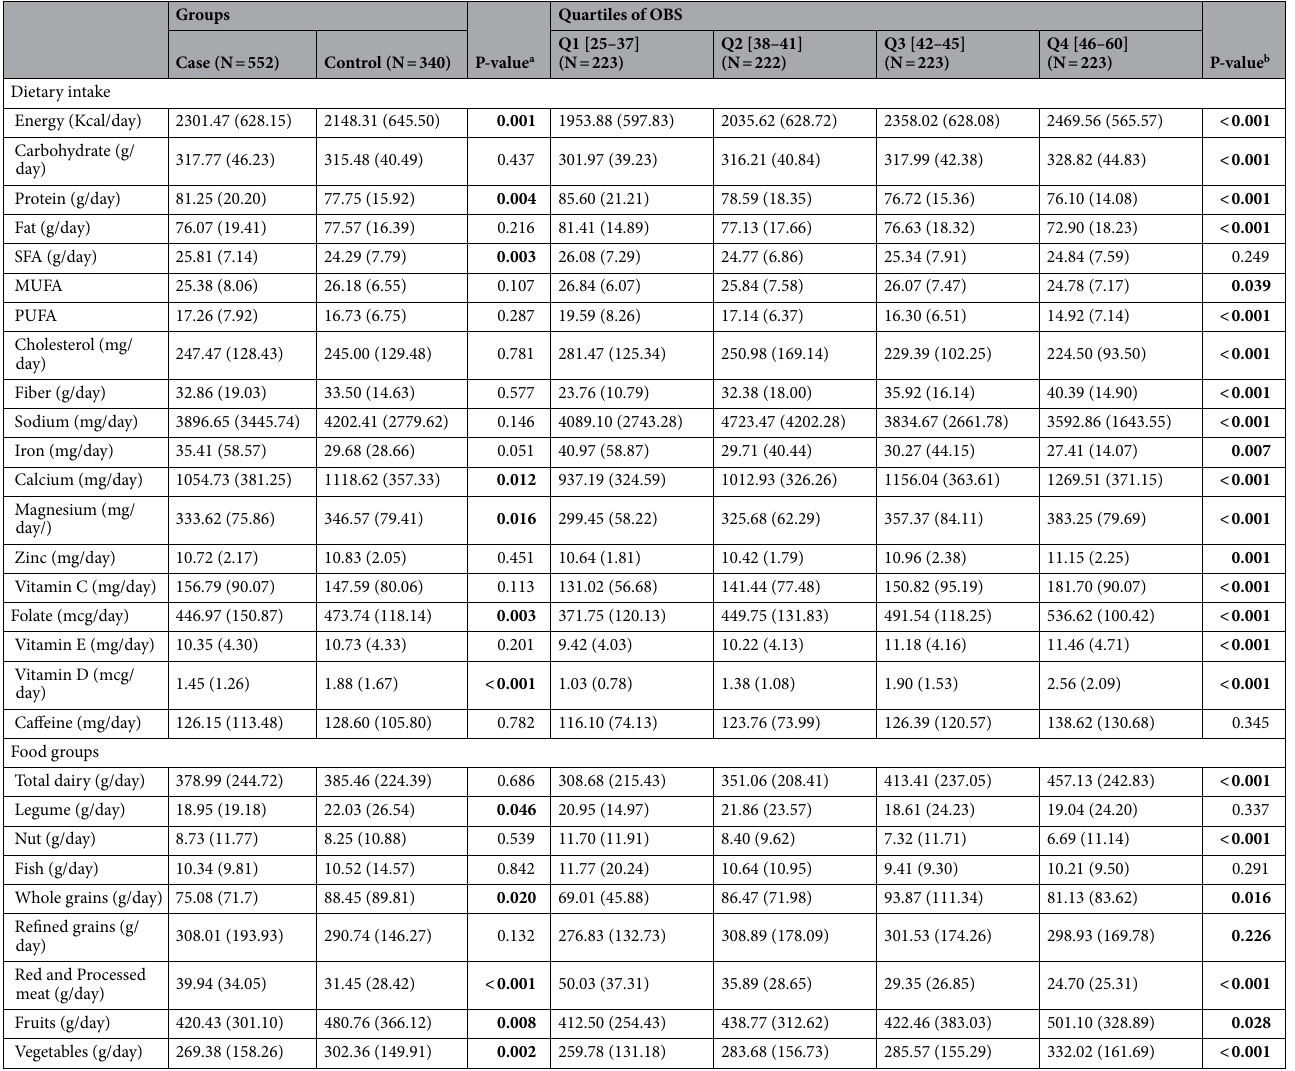
Table 2. Dietary intake between groups and across the Quartiles of oxidative balance score (OBS). Values are expressed as means (standard deviation (SD)) of 892 subjects. Nutrients were adjusted for total energy intake (kcal). Significant values are in bold. P-values are resulted from one way-ANOVA b Test or independent sample T-Test a for continuous variables. PUFA polyunsaturated fatty acid, SFA saturated fatty acid, MUFA monounsaturated fatty acid.